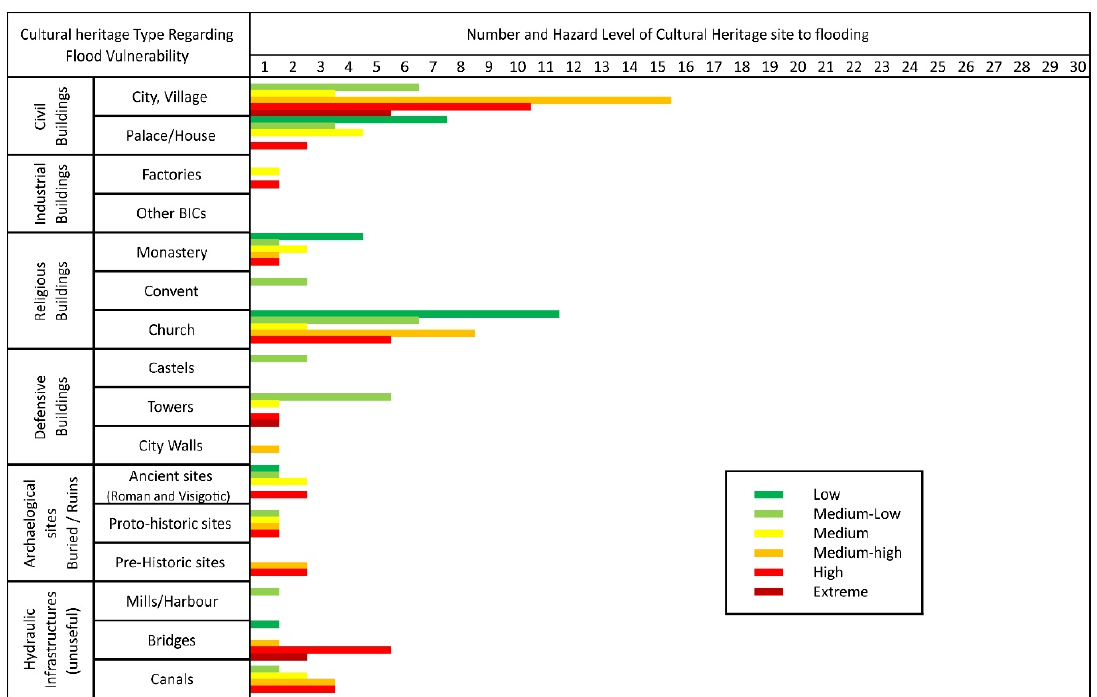
Figure 4. Distribution of flood hazard levels for the different cultural heritage types defined for Castile and León region.